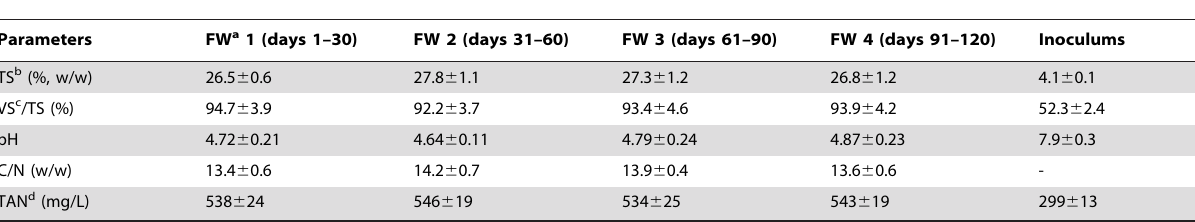
Table 1. Characteristics of the substrates and inoculums.